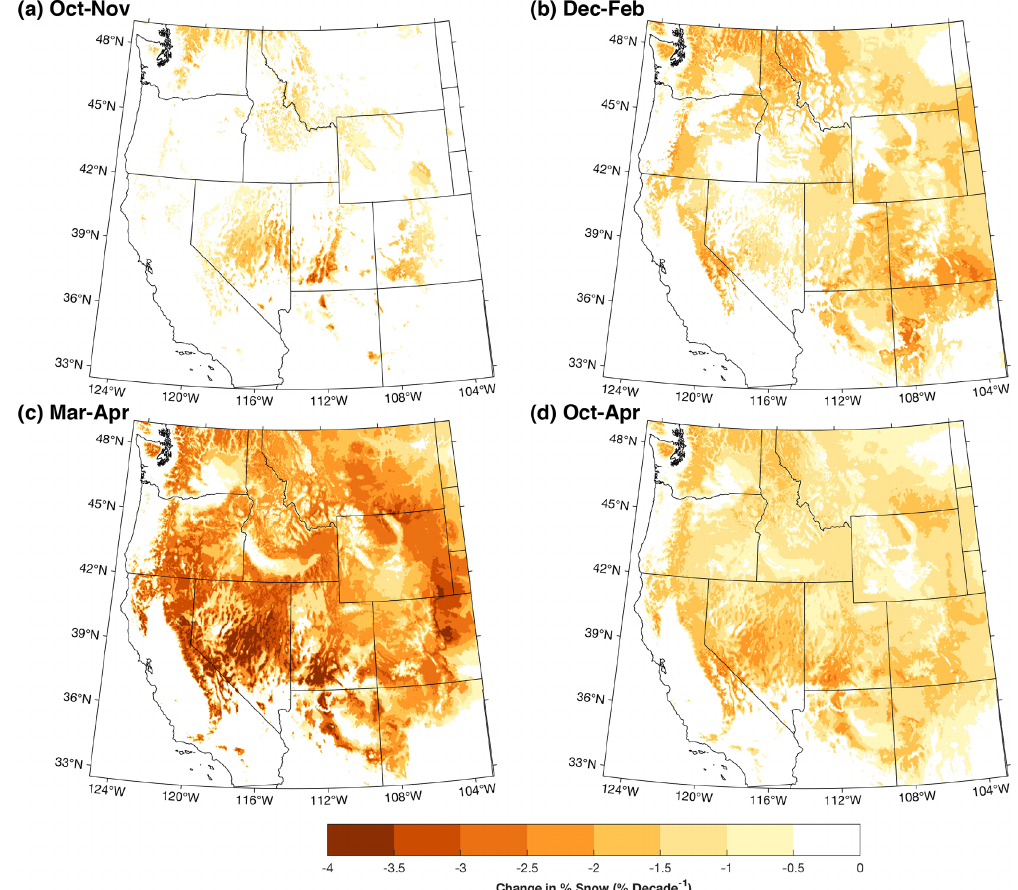
Figure 6. Decadal trends in % SNOW for the western United States during (a) fall (October–November), (b) winter (December–February), (c) spring (March–April), and (d) for the cool season of the water year (October–April). Only grid points with statistically significant ( p < 0 . 05) trends are shown; all grid point trends are shown in Fig.